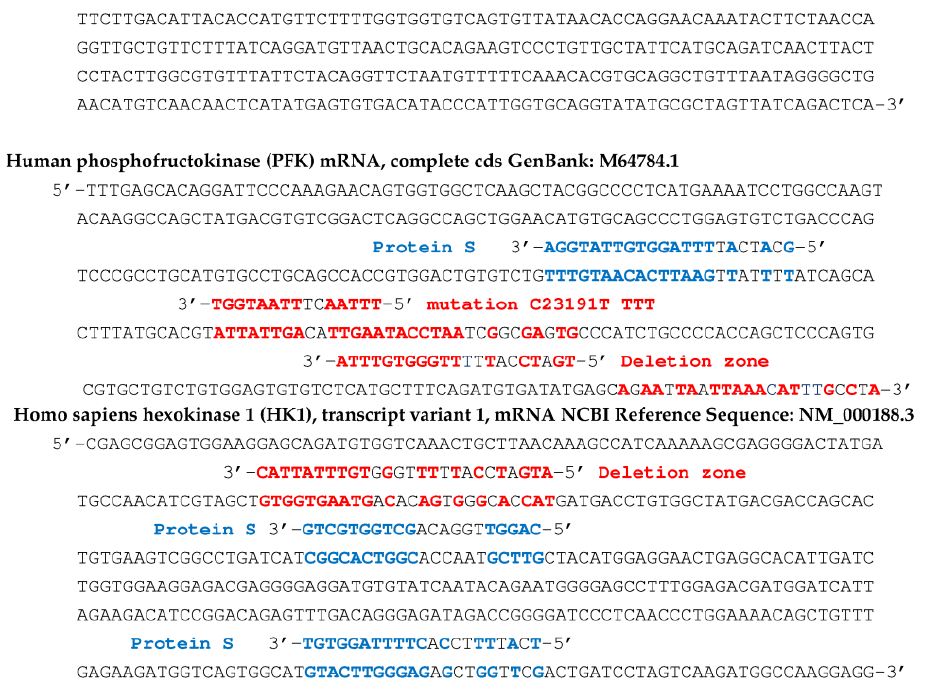
Figure 9. Top: partial sequence of the S protein gene of the SARS-CoV-2 virus. The first blue subse- quence of length 20 hybridizes adult hemoglobin subunit beta-globin (HBB)80, phosphofructokinase (PFK), hexokinase 1 (HK1), serpin family C member 1 (SERPINC1) and C-reactive protein (CRP). The second of length 22 hybridizes a mRNA subsequence of the hemoglobin subunit gamma-globin 2 (HBG2). In the middle (respectively, bottom), possible target subsequences from PFK (respectively, HK1) gene. Blue color indicates sequences of Protein S mRNA anti-matching human genes and red color indicates deletion or mutation zones of Protein S